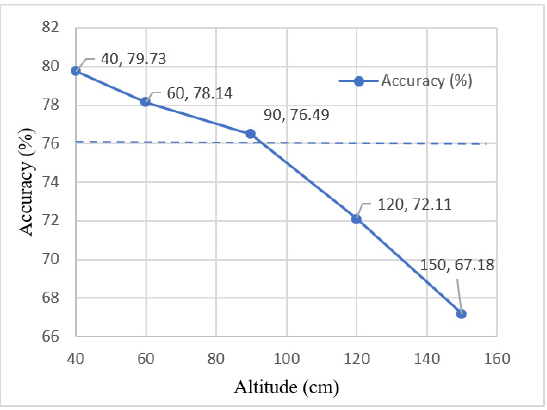
Figure 5. Accuracy of chemical at different altitude of sensors. Table 1. Determines the accuracy of chemical at different height of sensors.